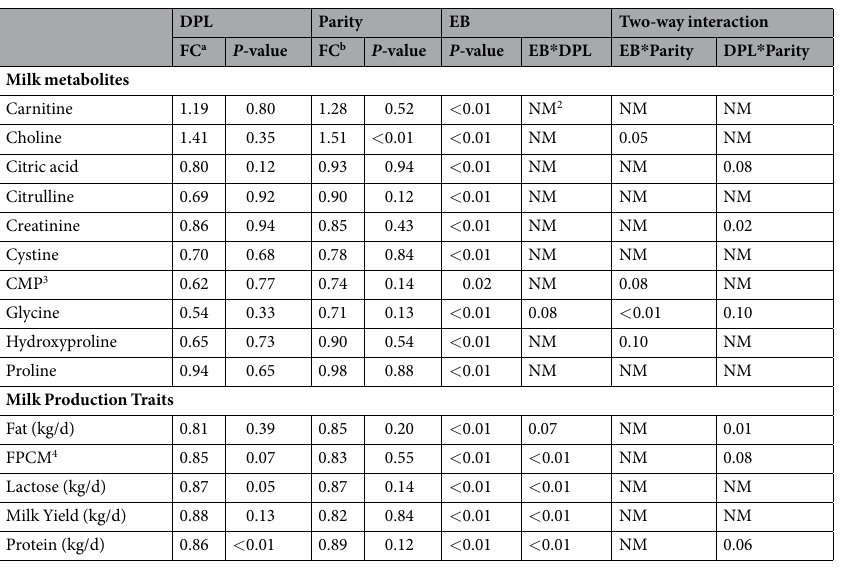
Table 1. The effect of dry period length (DPL), parity and energy balance (EB), on 10 milk metabolites and 5 milk production traits obtained through partial least squares analysis in lactation week 2. These 15 variables had a relatively higher VIP score 1 in week 2. a Fold change in the metabolite concentration (DPL 0/30). b Fold change in the metabolite concentration (parity 2/3). 1 Variable importance in projection score in partial least squares analysis. 2 NM: Not included in model. 3 CMP: Cytidine monophosphate. 4 FPCM, fat- and protein-corrected